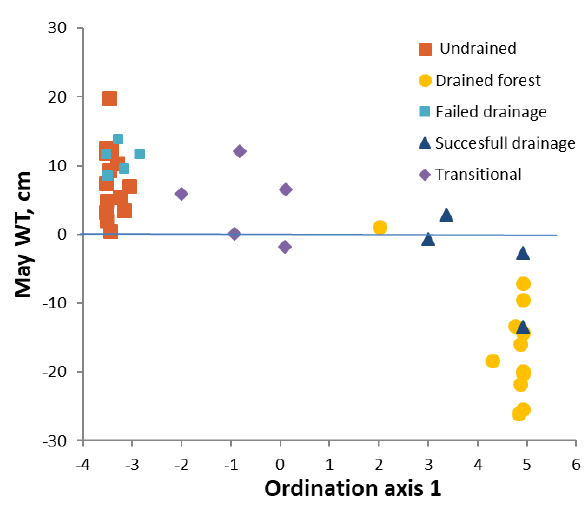
Figure 4. Relationship between average May WT and sample plot scores along the CCA Ordination Axis 1 (see Figure 2 for the ordination). Residual variation is added to the Undrained and Drained forest plot scores shown in Figure